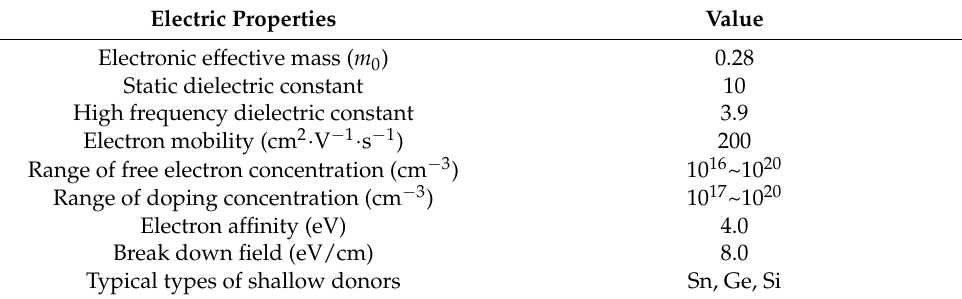
Table 2. Basic electric properties of β -Ga 2 O 3